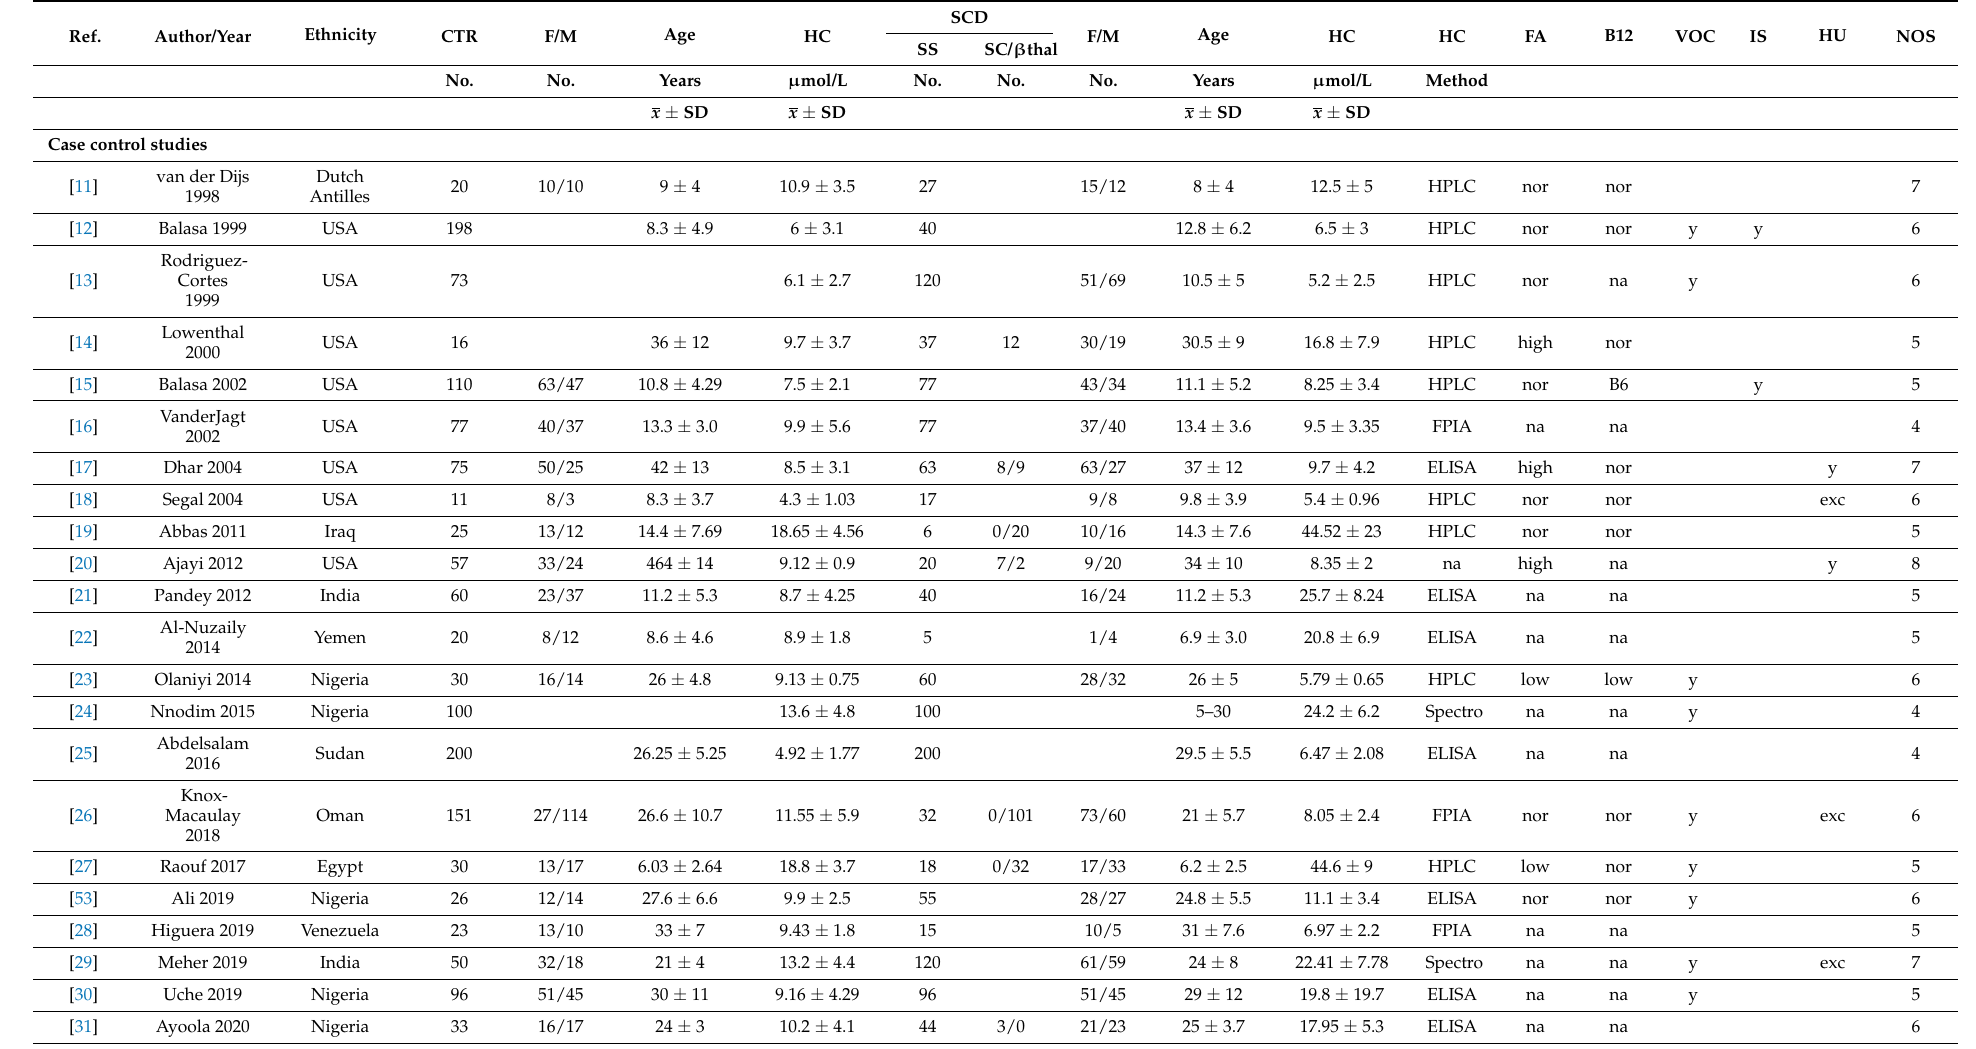
Table 1. Demographics and clinical features of the case control and cohort studies on plasma